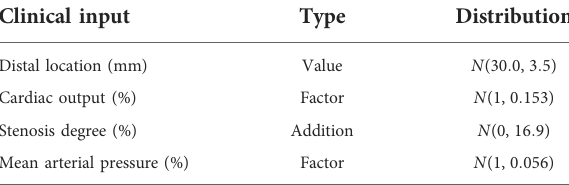
TABLE 1 Input parameter bounds to study the impact of patient- speci fi city on FFR. Clinical